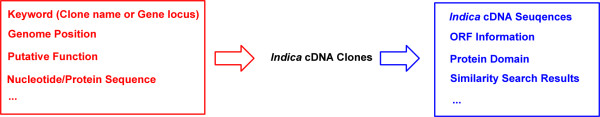
Query and display of cDNA clones in Rice Indica cDNA Database. The query parts are in red, while the display parts are in blue.